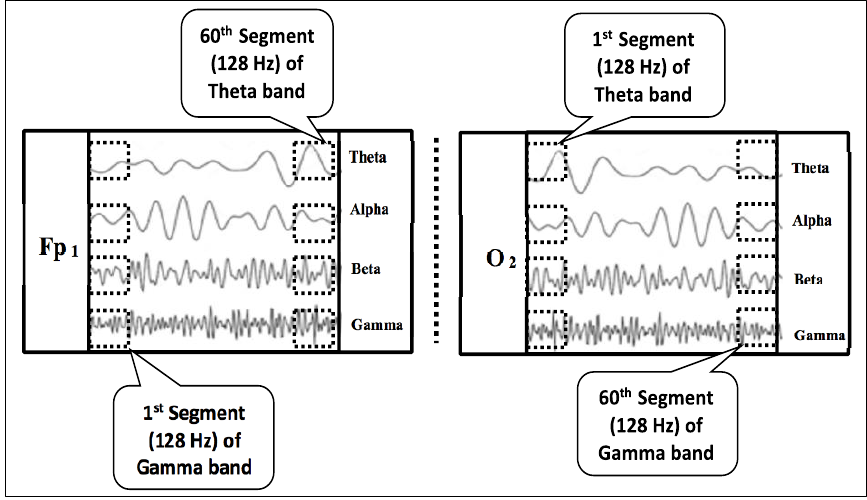
Figure 4. The segmentation process of EEG signals in the first experiment (sixty